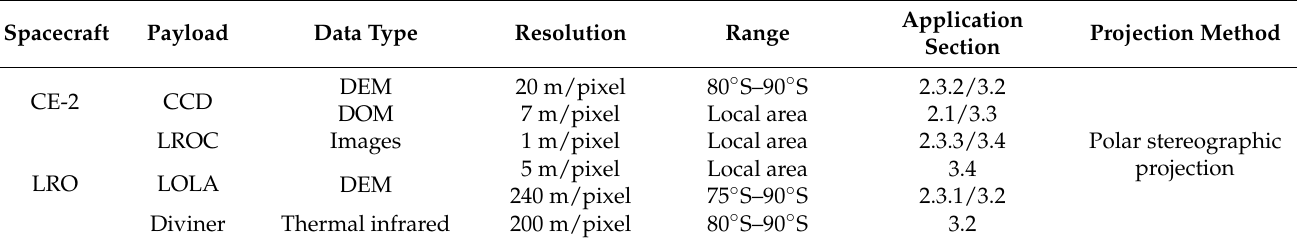
Table 1. The data used in this paper.